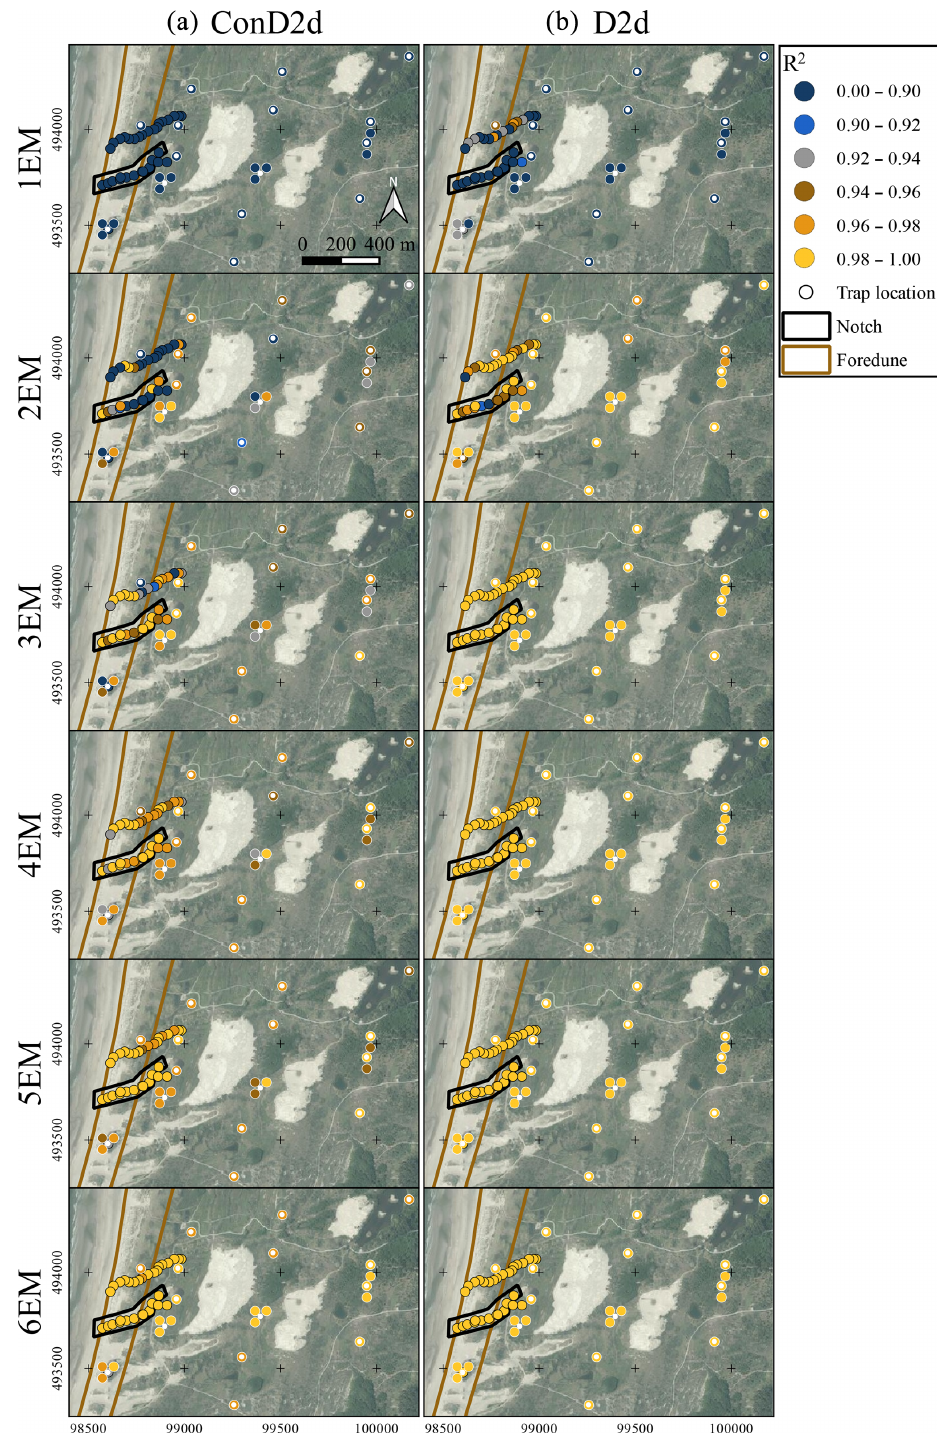
Figure A9. Sample-wise R 2 plotted over the sample locations for variable ConD2d (a) and variable D2d (b) . The first interval of the colour scale is enlarged to elucidate the changes in R 2 , which mainly occur above a value of 0.9. Points with a black outline denote surface samples and are plotted at the sampling location. Points with a white outline denote sediment-trap samples and are plotted near the sampling location. The exact locations of sediment traps are marked by white dots. Two of the subregions defined in Fig. 1c are shown in simplified form. Aerial photograph © PDOK.nl,